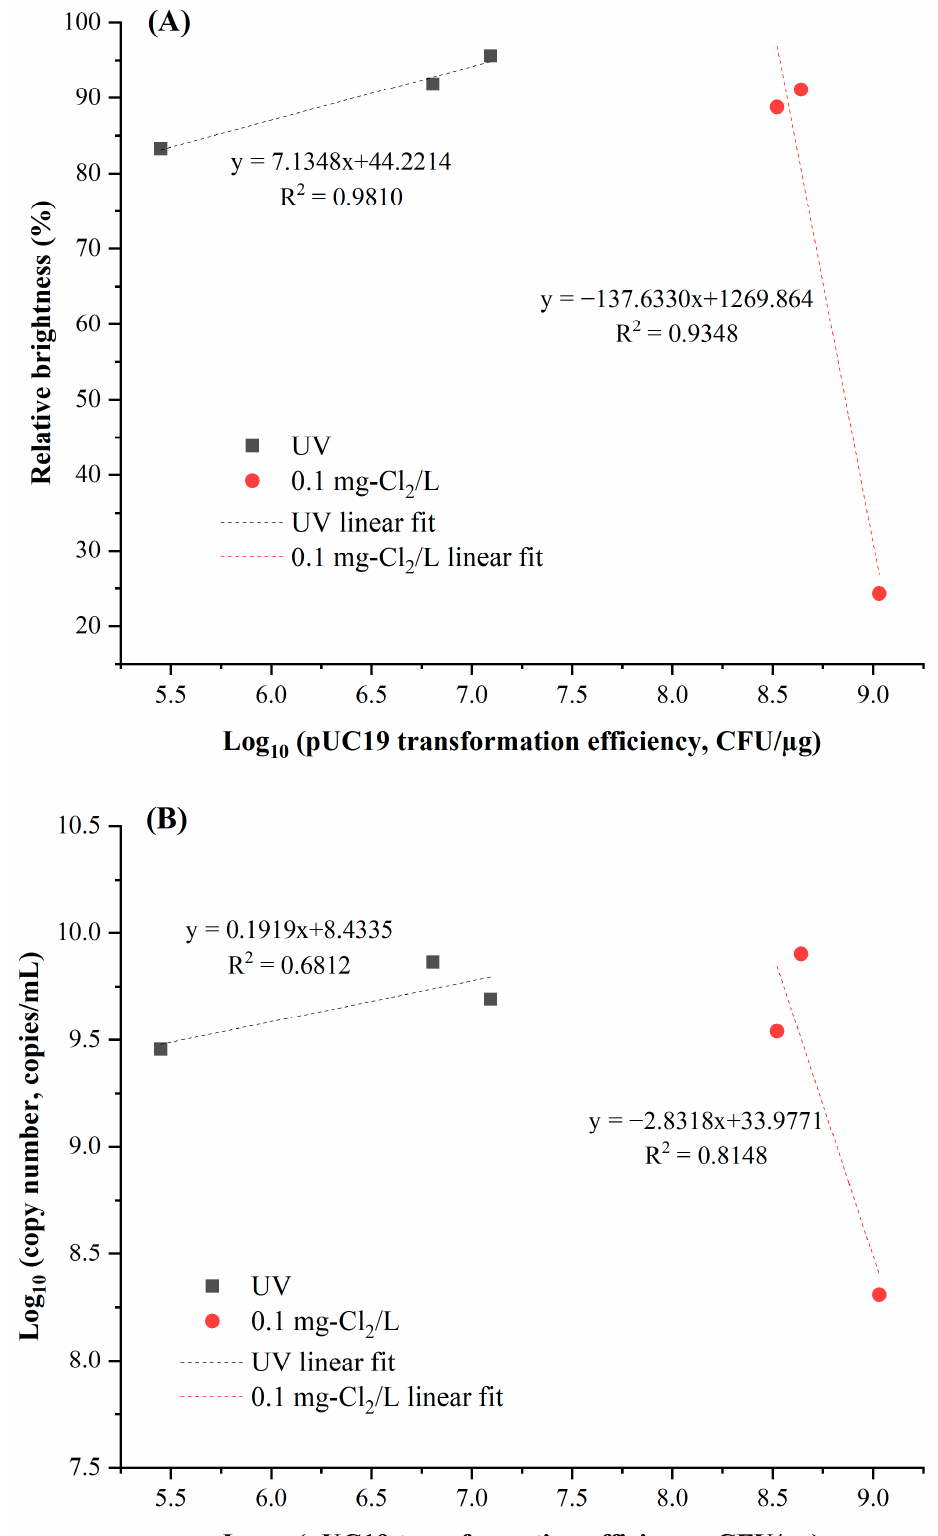
Figure 5. Relationship analysis of transformation efficiency with ( A ) the band intensity of pUC19 PCR products after electrophoresis and ( B ) pUC19 copy numbers by qPCR.